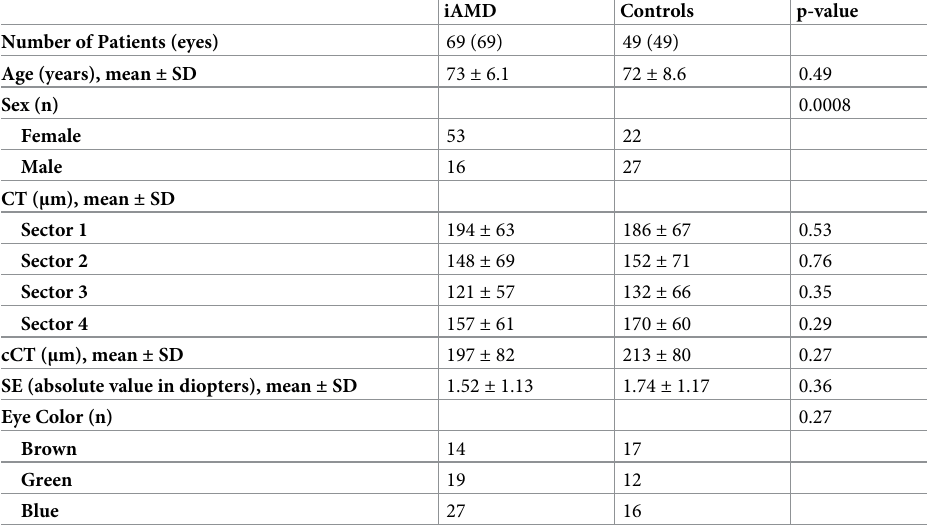
Table 1. Demographic and clinical characteristics of AMD patients and controls.